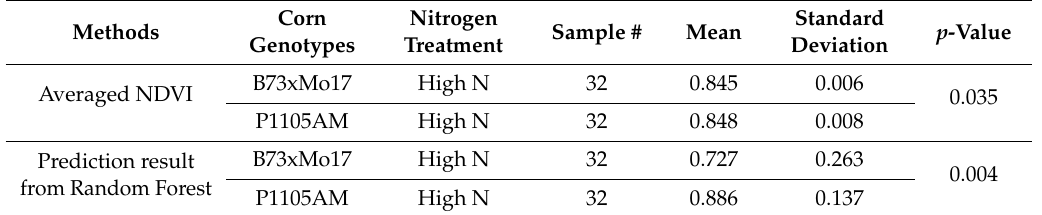
Table 4. The comparison results of the conventional averaged NDVI and the prediction results from Random Forest.